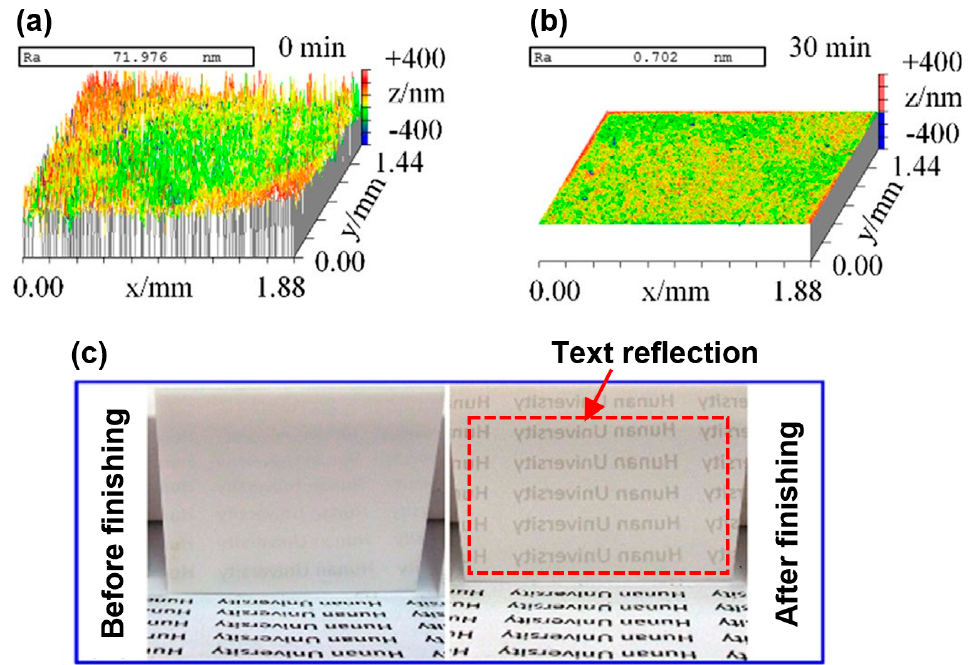
Figure 9. Experimental setup of magnetorheological finishing of zirconia ceramics (a) permanent magnetic yoke and (b) experimental setup, reused with permission from Elsevier [61].